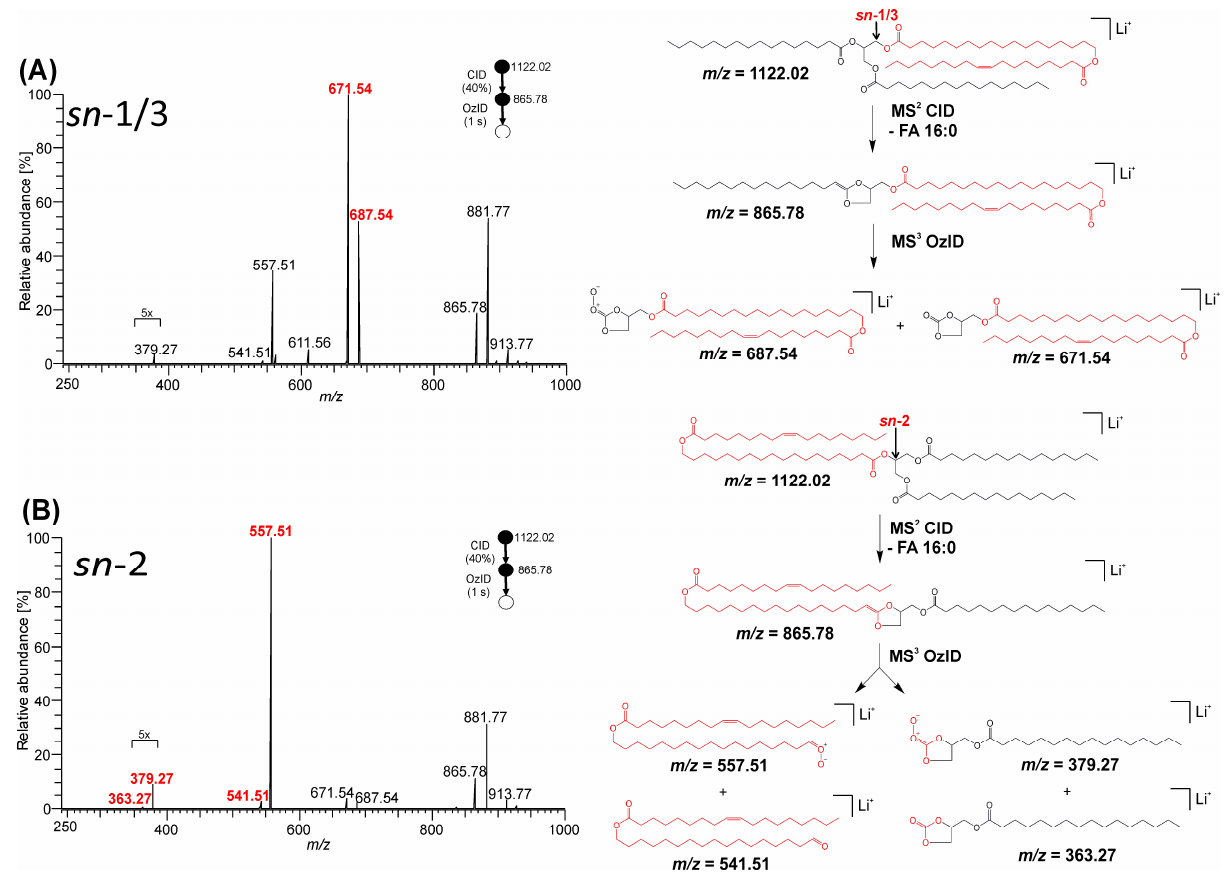
Figure 7. MS 3 CID/OzID spectra of TG ‐ EST [M + Li] + . The CID product ion at m/z 865.78 corresponding to neutral loss of palmitic acid was re ‐ isolated and allowed to react with ozone: ( A ) TG ‐ EST 7 — sn ‐ 1/3 ‐ isomer; ( B ) TG ‐ EST 8 — sn ‐ 2 ‐ isomer. Diagnostic product ions for the various positional isomers are highlighted in red. Selected product ion abundances were magnified, as indicated.